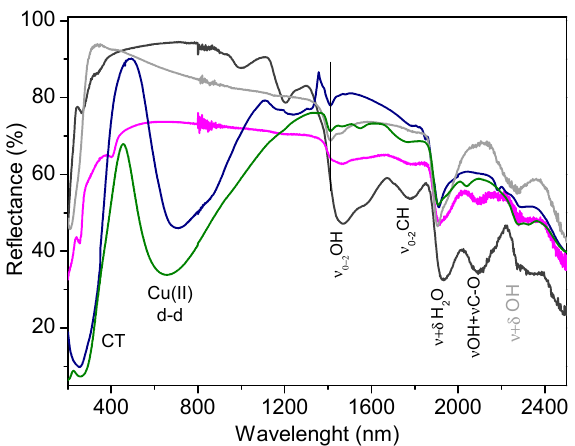
Figure 6. Diffuse reflectance DR UV-Vis-NIR spectra of: SiO 2 (grey); β -CD (black); Si-NH-CD (pink); Si-NH-Cu-CD (blue); and Si-diAm-Cu-CD (green). 2.3. Test of the Catalytic Activity of Copper Supported on Si-NH-CD and Si-DETA-CD Cu(II)- β -CD has been proven to be a reliable, water-soluble, green catalyst for 1,2,3-triazole